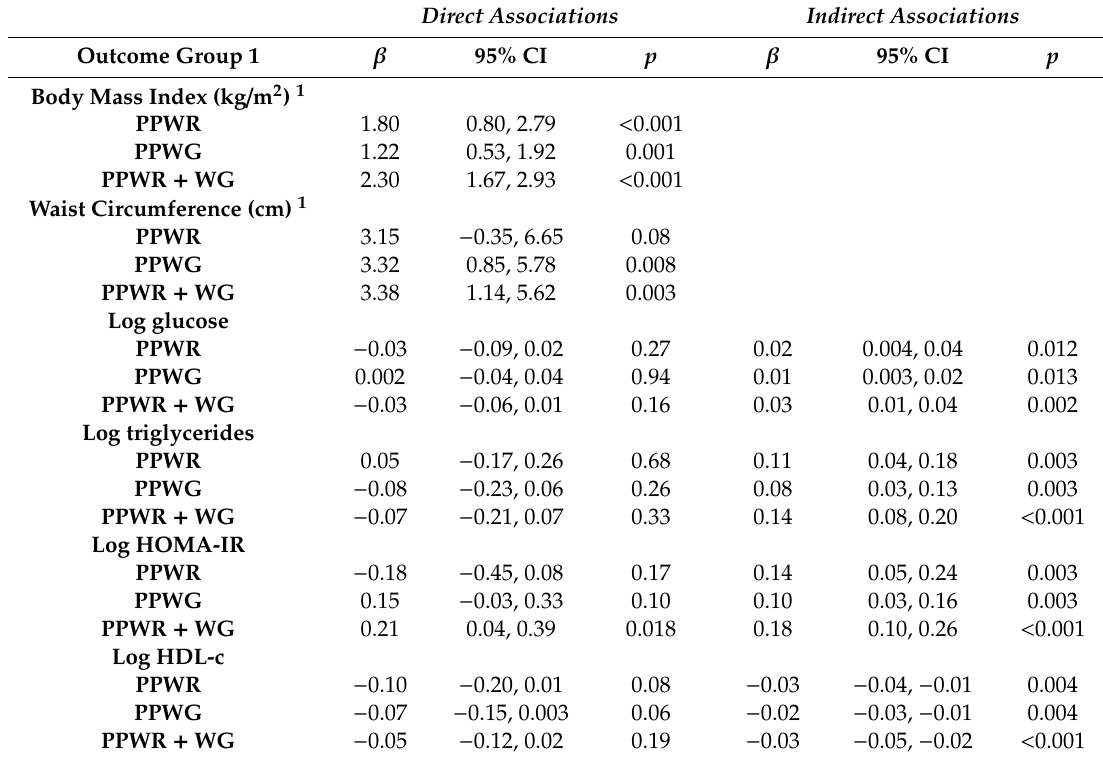
Table 2. Path coe ffi cients and 95% CI for the association between patterns of weight change one year after delivery with adiposity and selected cardiometabolic outcomes at six years postpartum. Direct Associations Indirect